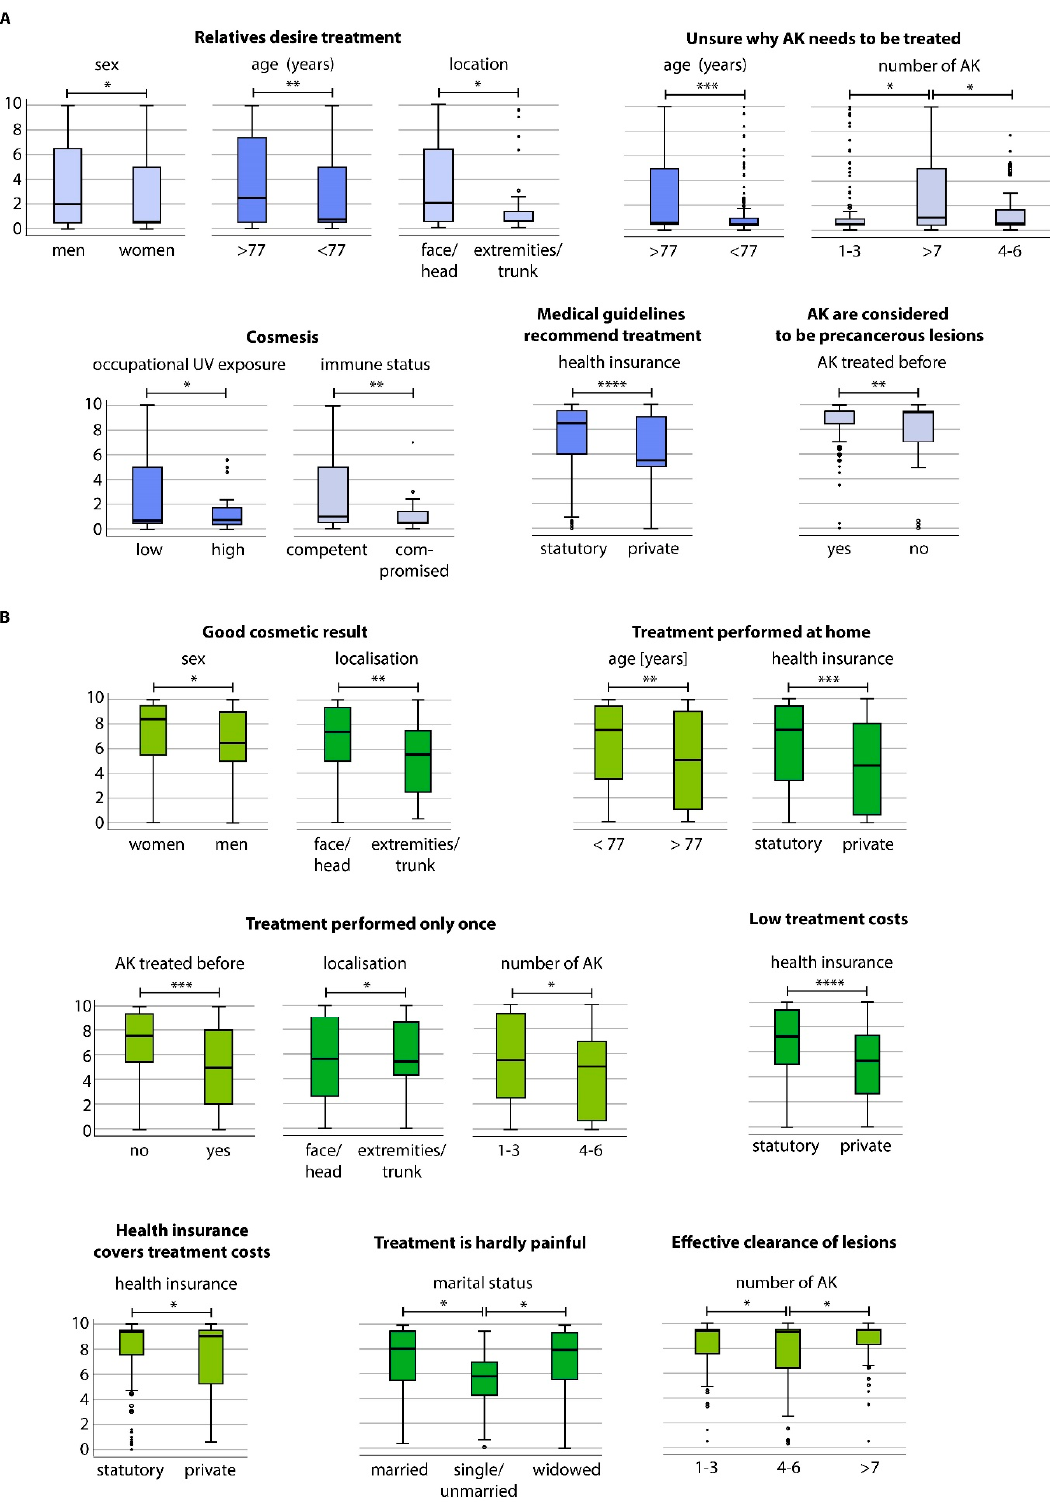
Figure 2. Boxplots showing patients’ specific subgroup evaluation on ( A ) motivation for a therapy of their AK and ( B ) on expectations for the therapy of AK; p -values: * < 0.05; ** < 0.01; *** = 0.001; **** = 0.000.